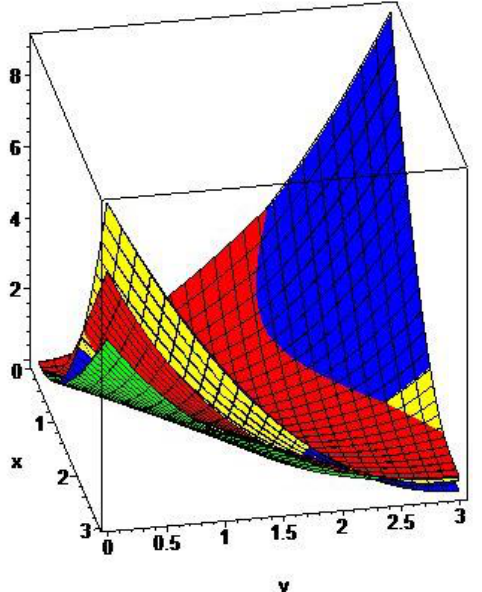
( ϕ ) (red) and B G ( ϕ ) (yellow) 75,75 75,75